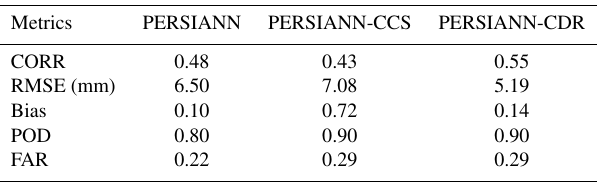
Table 3. Summary of comparison metrics for the PERSIANN fam- ily of products against the CPC for the period (2003 to 2015) over the